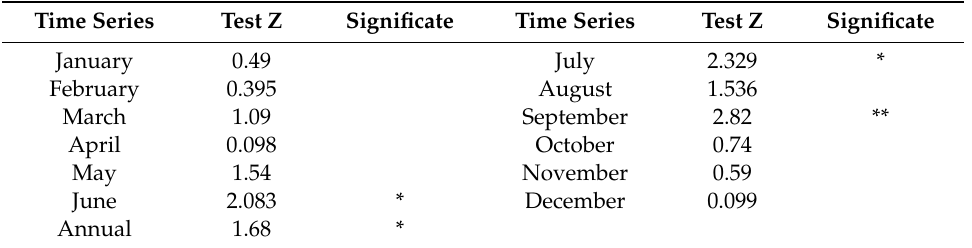
Table 1. Mann–Kendall statistics for mean land surface temperature in Africa during 2003–2017. Time Series Test Z Significate Time Series Test Z